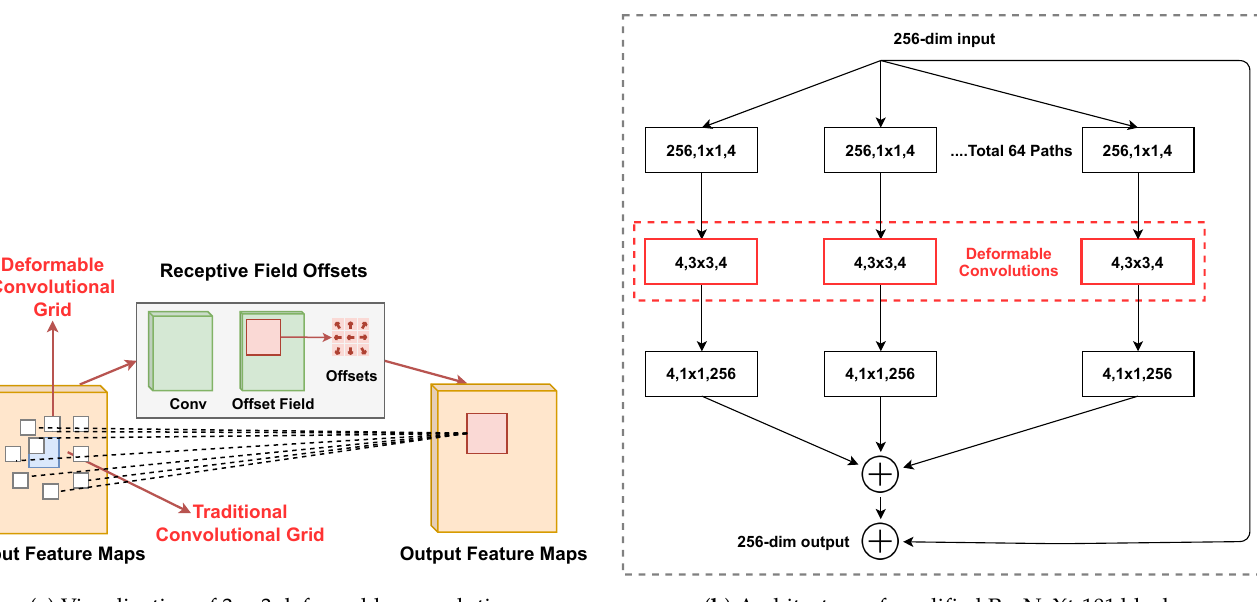
Figure 2. The components of our feature extraction pipeline. Part ( a ) shows the structure of deformable convolutions where the traditional convolutional grid (in blue) is transformed into deformable grid (in white) by adding 2D offsets. Part ( b ) shows that the conventional convolutions are replaced with deformable convolutions in ResNeXt-101 to extract tables at multiple